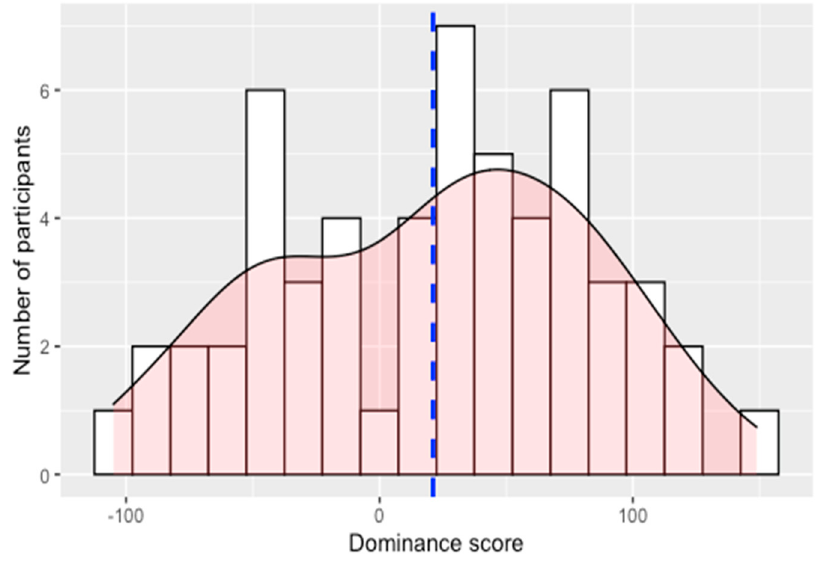
Figure 1. Histogram (bin width = 15) and density plot of participants’ dominance scores. Positive scores indicate Spanish dominance, and negative scores indicate English dominance. The vertical dotted line indicates the mean. Table 1. Summary of participant characteristics. For the sake of illustration, participants are divided into the groups “Span- ish-dominant” and “English-dominant” based on a zero split; however, there was no group variable in any of our infer- ential analyses.